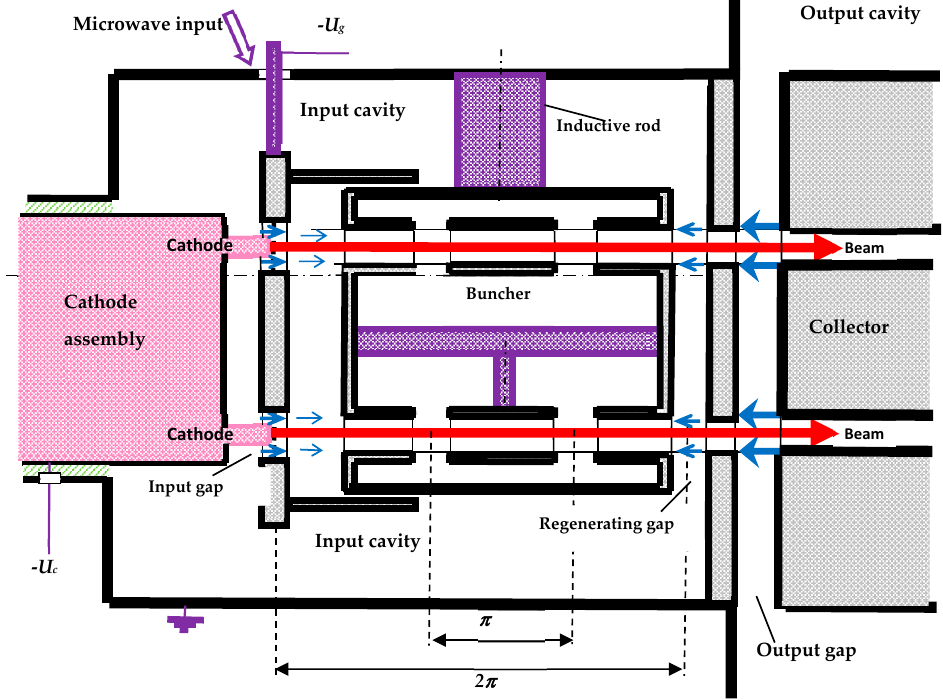
Figure 19. Scheme of a multi-beam resotrode with 2 π -regeneration. The blue arrows indicate the electric microwave field, and their thickness illustrates the size of the field .